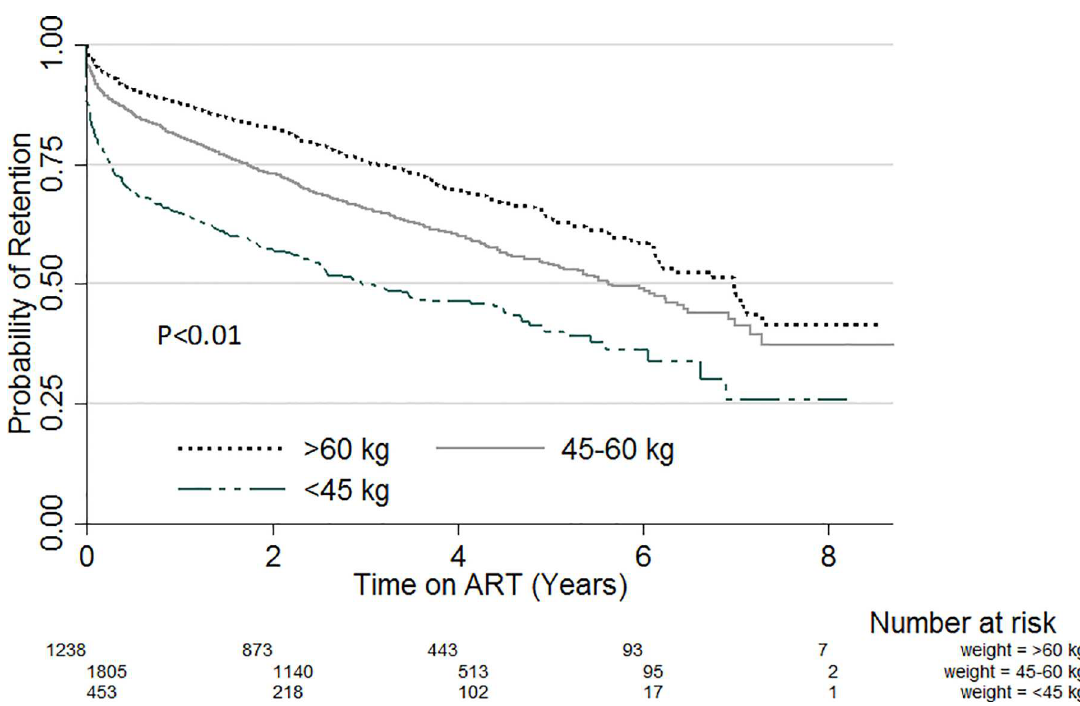
Fig 4. ART retention stratified by weight at ART